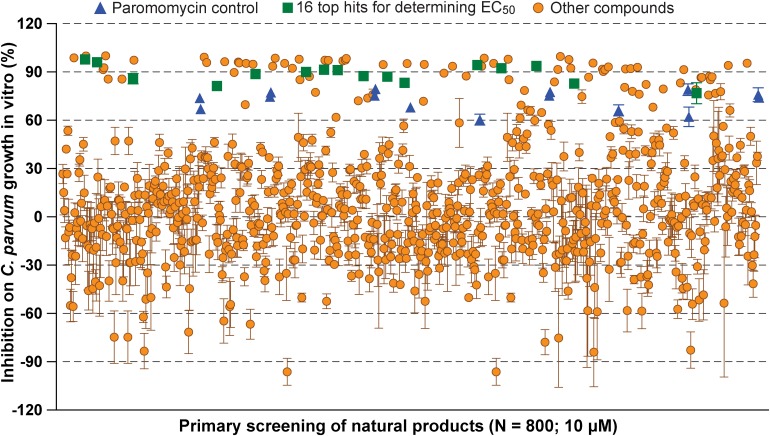
Scatter plot of the primary screening of 800 natural products (10 μM) against the growth of Cryptosporidium parvum in vitro. Blue triangles represent data from the positive control compound paromomycin (150 μM). Green squares represent the 16 top hits selected for determining their antiparasitic half maximal effective concentration (EC50) values and cytotoxicity shown in Table 1 and Figure 2. Each plate included 0.5% dimethyl sulfoxide diluent only as negative control (6 wells/plate). Bars show the standard error of the mean (N ≥ 3).